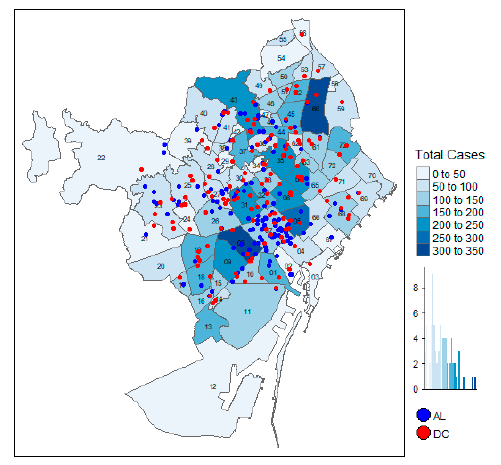
Figure 5. Location of AL / DC and total